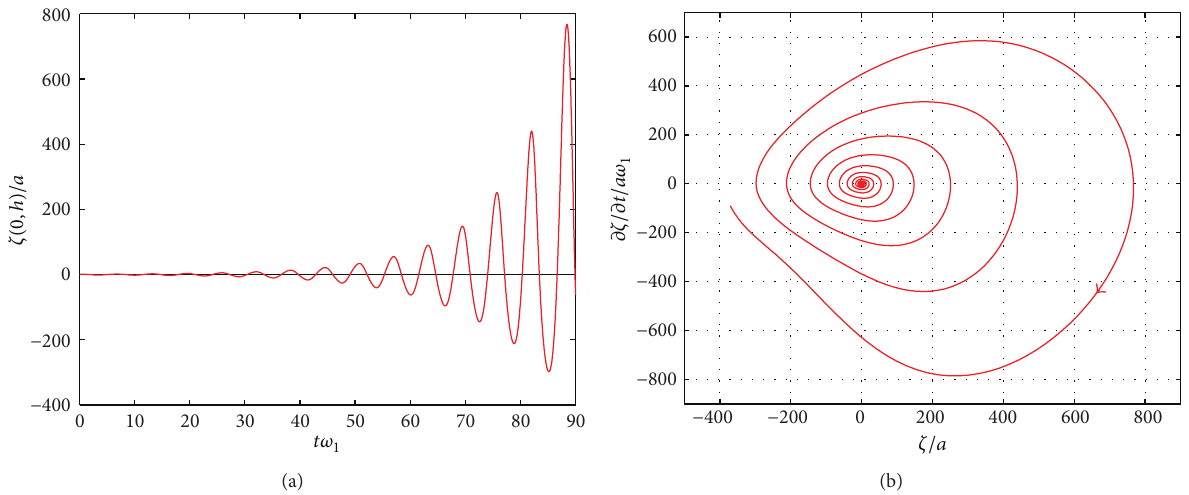
Figure 6: Free-surface elevation on the left wall in the unstable region (test case 2) for Ω 1 = 0.5 , 𝑘 V = 0.5 , 𝜀 = 0.0014 , and the respective phase-plane plot.